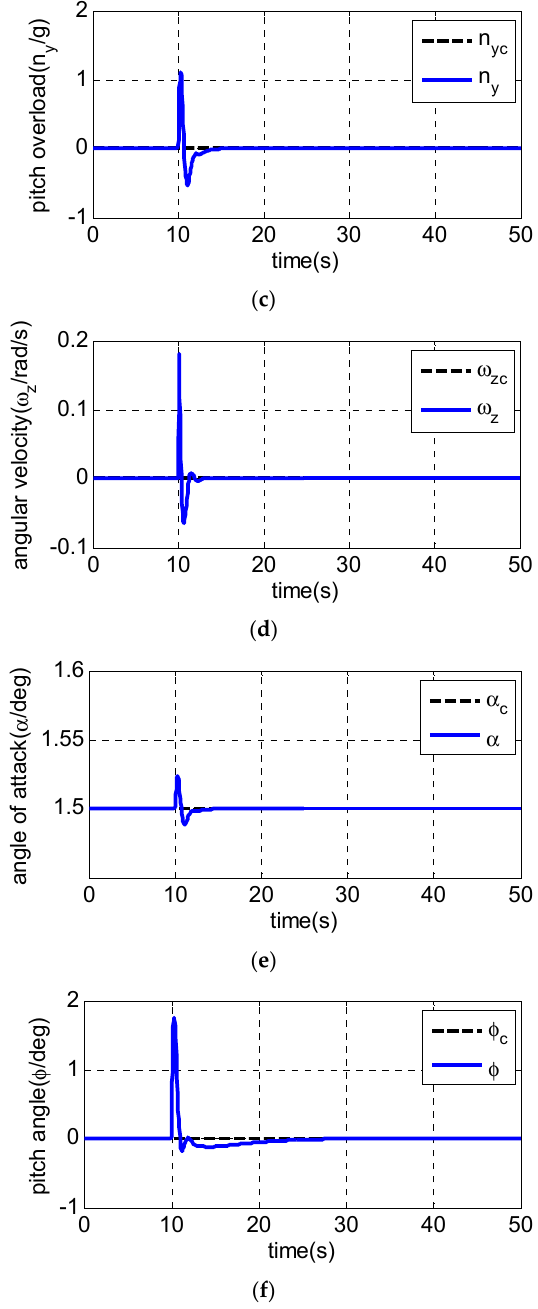
Figure 2. Simulation results in case of sudden failures of the actuator: ( a ) 3D trajectory; ( b ) altitude; ( c ) pitch overload; ( d ) angular velocity; ( e ) attack angle; and ( f ) pitch angle.